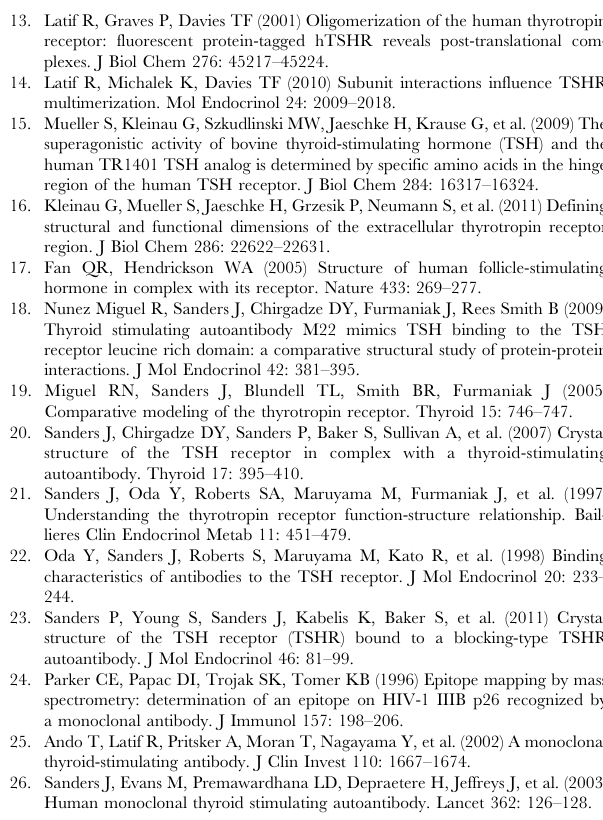
Figure S1 The peptide sequence of the entire TSH receptor ECD is shown in black letters in the top and bottom panels. The MS-1 protected peptides shown in the top panel (marked in red) and M22 protected peptide sequences shown in bottom panel (marked in